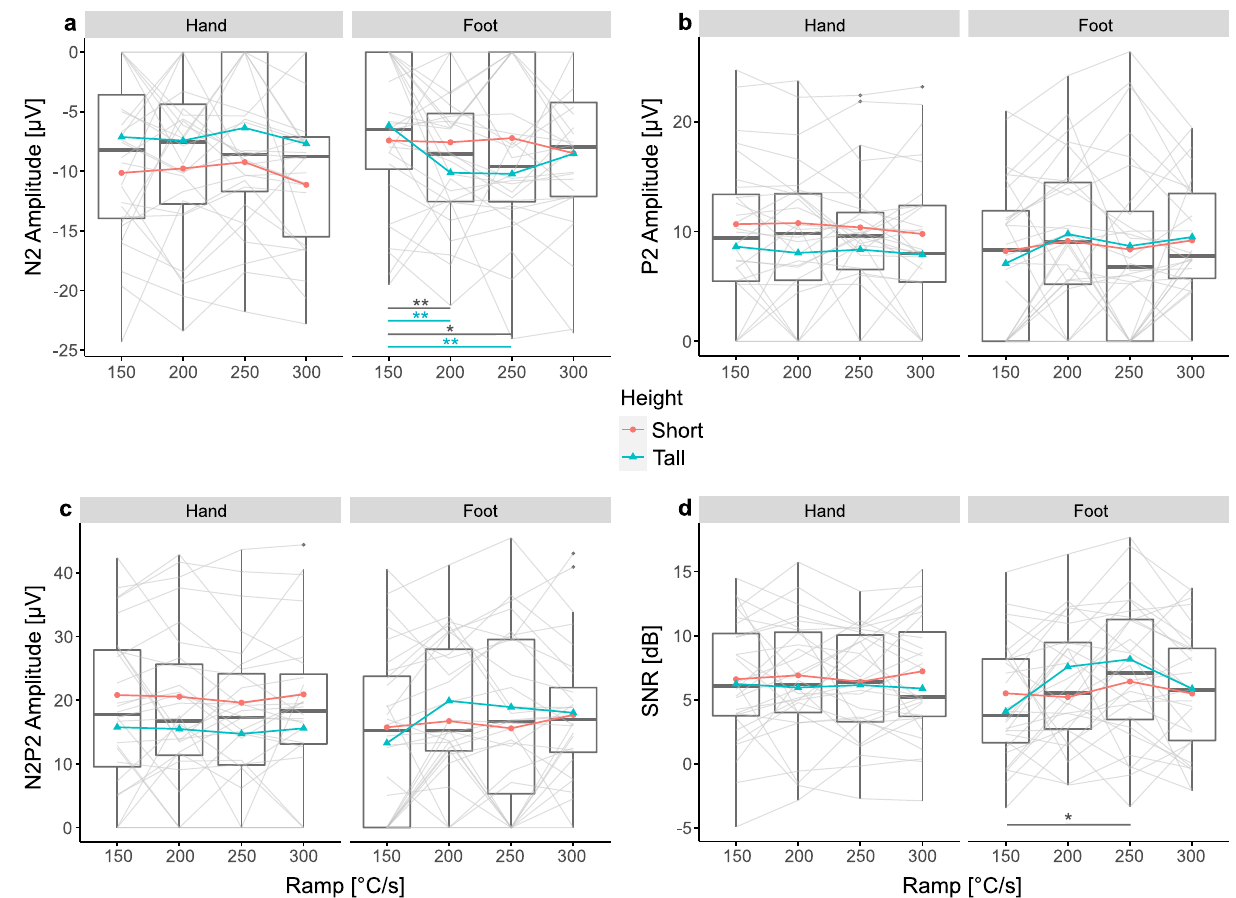
Figure 5. Contact heat evoked potential (CHEP) amplitudes and signal-to-noise ratio (SNR) after contact heat stimulations with four different heating ramps. Hand and foot stimulations are illustrated on the left and right side, respectively. For an illustrative purpose, the mean of short (red) and tall (blue) subjects are shown; short < median height < tall. Significant differences due to the heating ramp are illustrated in grey. Significant interactions between heating ramp and height are illustrated in blue. ( a ) CHEP N2 amplitude. ( b ) CHEP P2 amplitude. ( c ) CHEP N2P2 amplitude. ( d ) CHEP SNR. *p < 0.05, **p < 0.01, ***p <